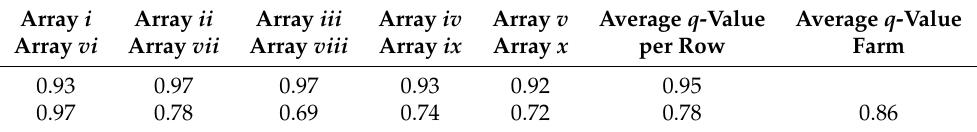
Table 9. WEC farm q -values for the 50 WEC farm for an irregular wave of H m 0 = 1.7 m and T p = 8.71 s.